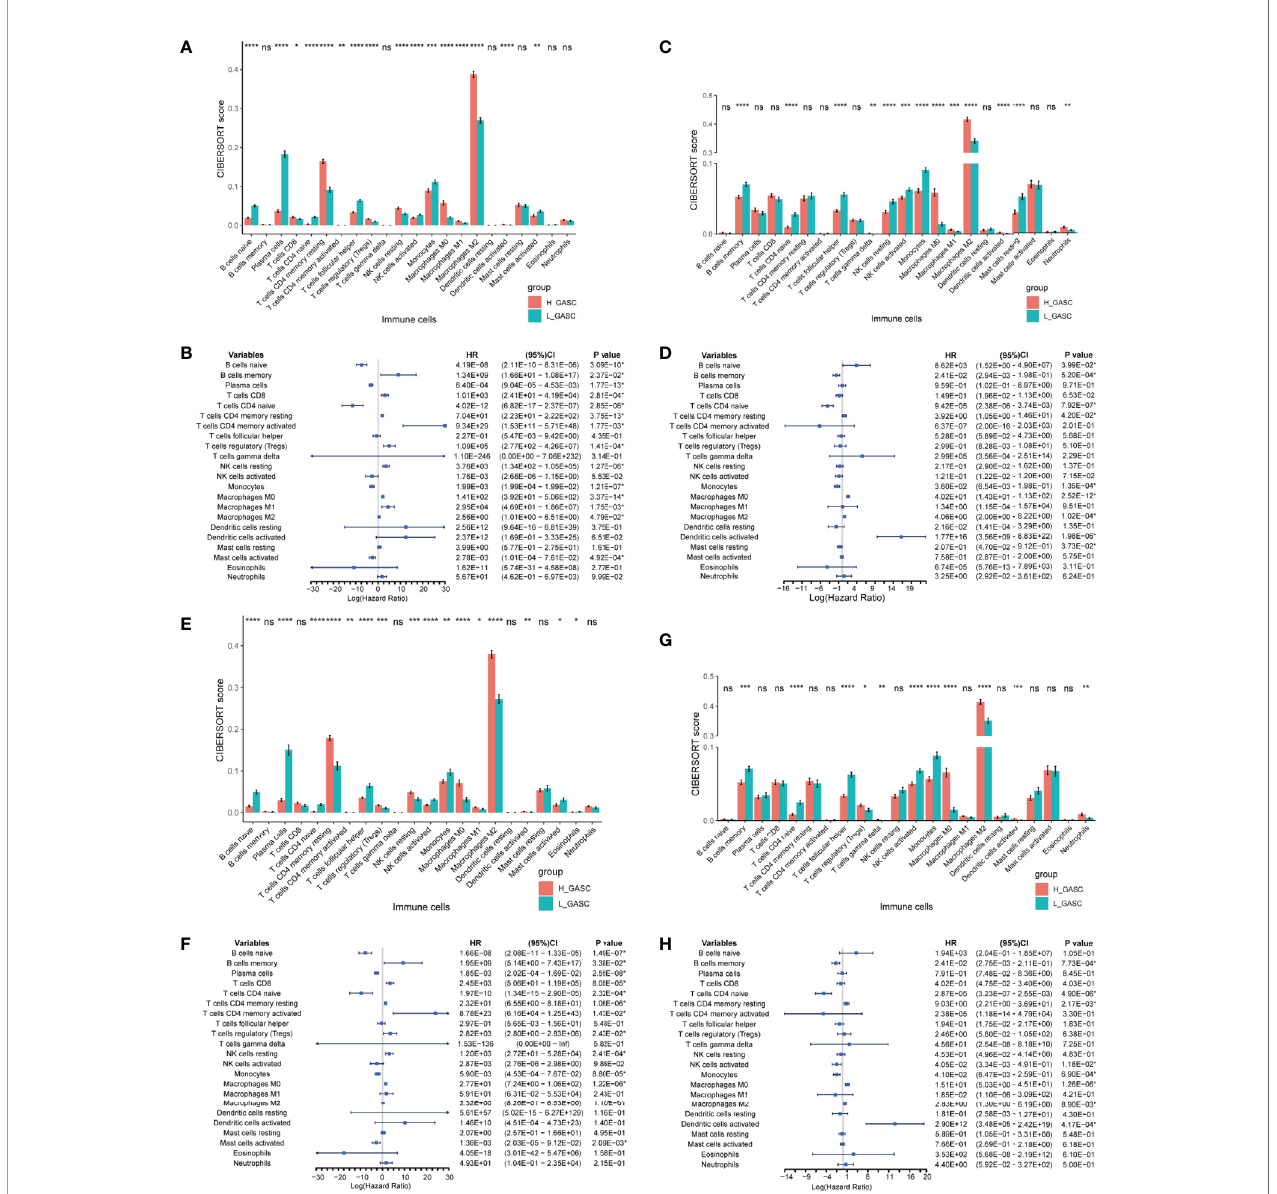
FIGURE 8 | Associations between GASCs and immune cells. (A, C, E, G) Bar charts illustrating the differences in CIBERSORT scores between high- and low- GASC groups in all glioma population ( A for TCGA and C for CGGA) and high-grade glioma population ( E for TCGA and G for CGGA). (B, D, F, H) Forest plots of univariate Cox regression analysis of immune cells in all glioma population ( B for TCGA and D for CGGA) and high-grade glioma population ( F for TCGA and H for CGGA). ns: p ≥ 0.05, * p ≤ 0.05, ** p ≤ 0.01, *** p ≤ 0.001, **** p ≤